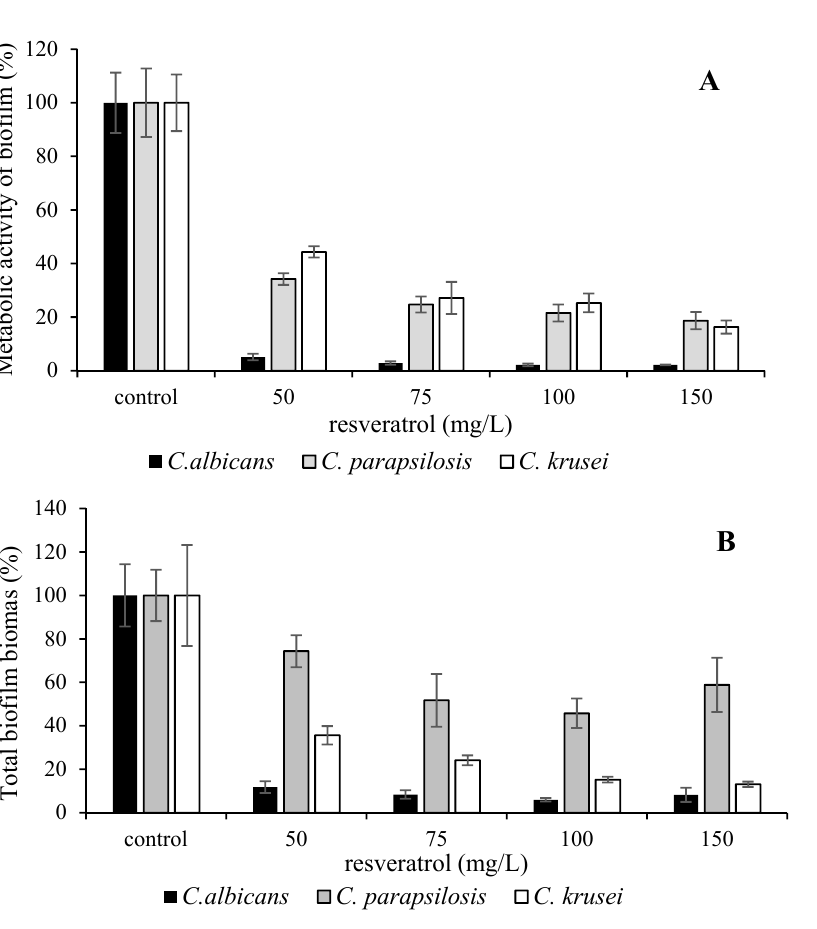
Figure 1. The influence of resveratrol in cane extract on C. albicans DBM 2164, C. parapsilosis DBM 2165 and C. krusei CCM 8271. The metabolic activity of biofilm ( A ); the total biofilm biomass ( B ); control 100% (no agent). Error bars represent standard deviation.